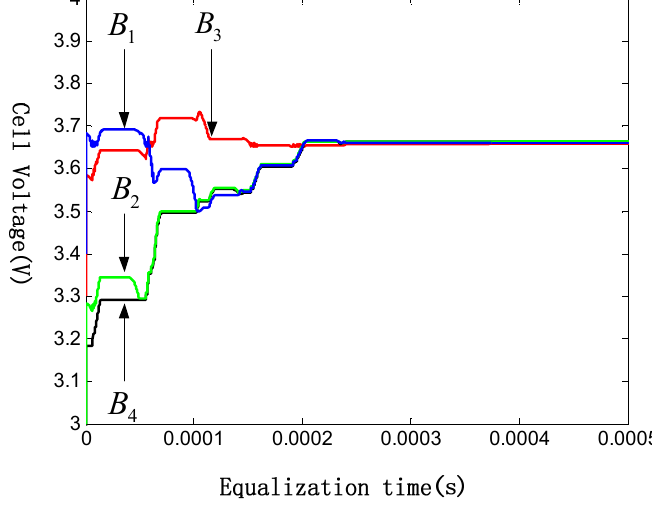
Figure 11. Cell voltages during charging state.